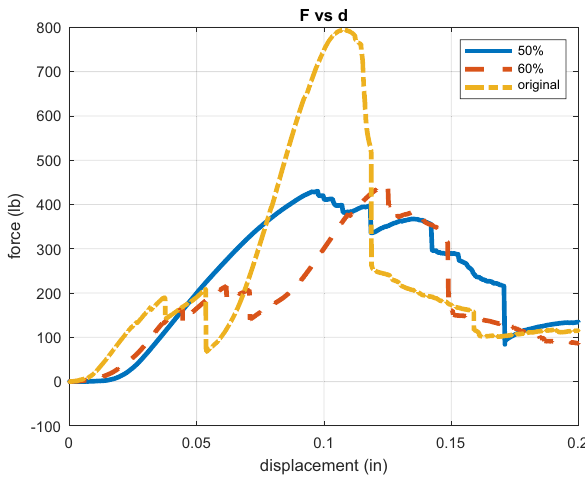
Figure 21: Force vs displacement curve of specimens under com - pression